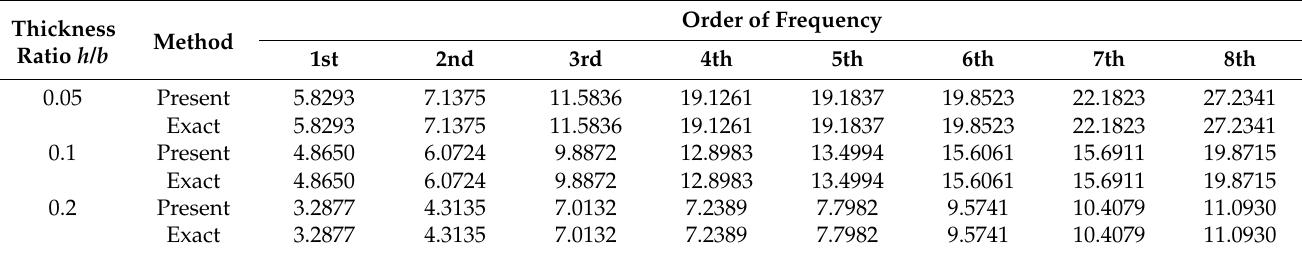
Table 10. The nondimensional frequency Ω for SCSF